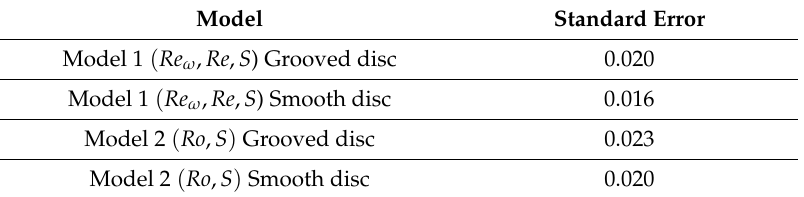
Table 3. Comparison of standard errors generated by the two empirical